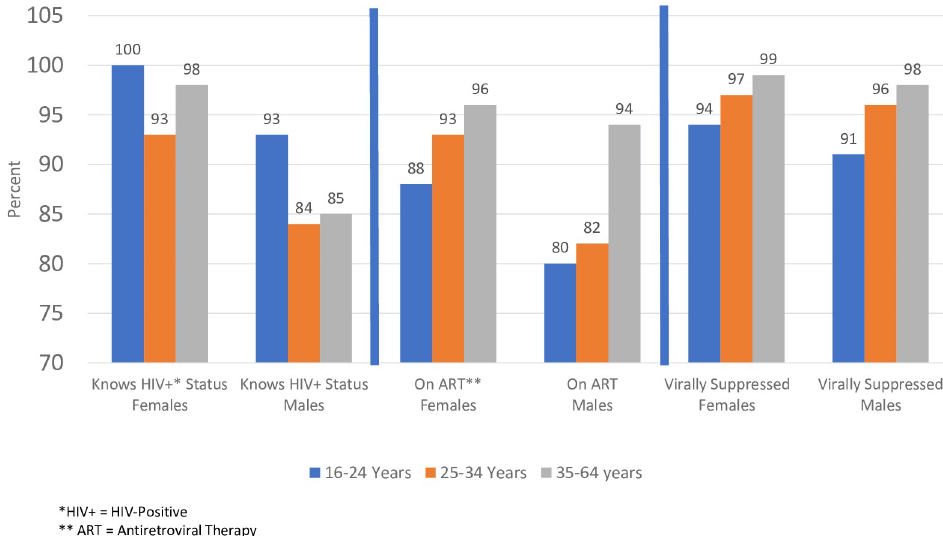
Fig 2. Knowledge of HIV-positive status, ART status, and viral suppression stratified by age and sex.